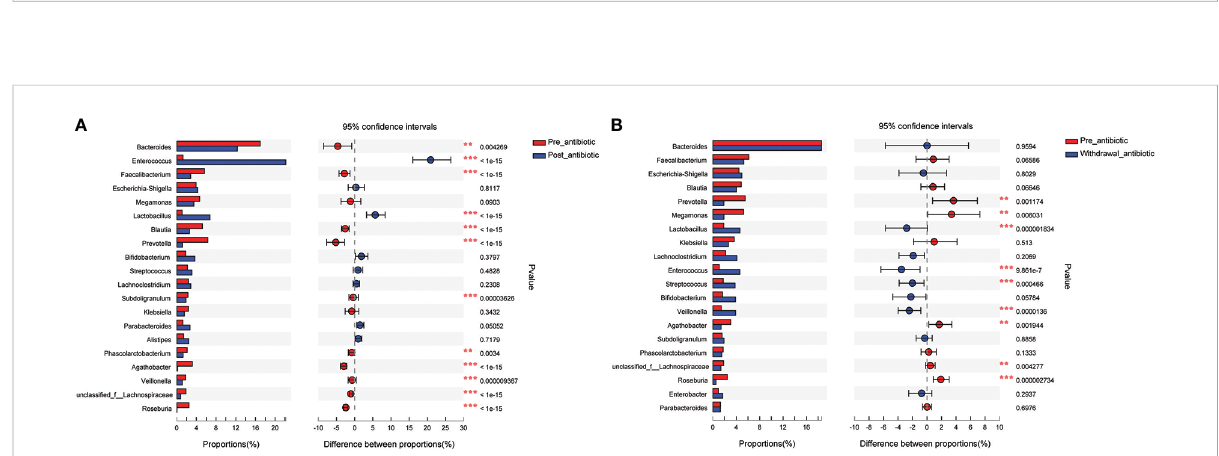
FIGURE 4 Comparison of the top 20 bacterial species in the antibiotics group. (A) : comparison between pre-antibiotic and post-antibiotic; (B) : comparison between pre-antibiotic and withdrawal-antibiotic. **P<0.01,